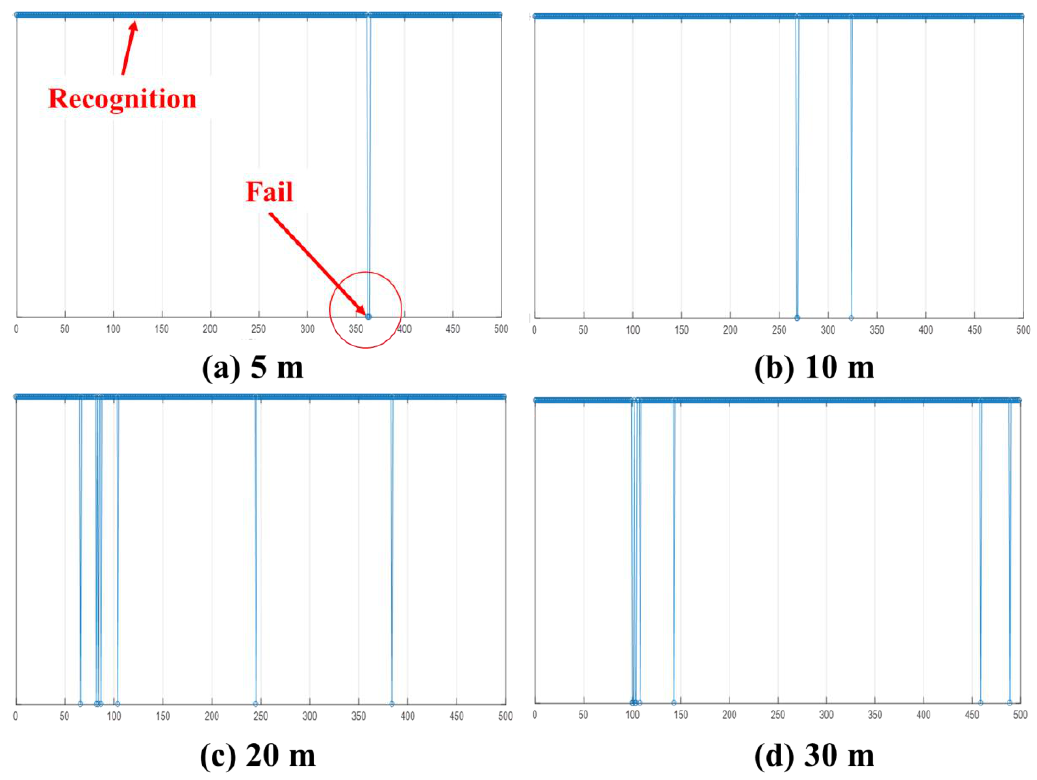
Figure 12. UWB communication between UMCU and PPU at ( a ) 5m, ( b ) 10m, ( c ) 20m, and ( d ) 30m. Table 8. Test result of recognition rate.